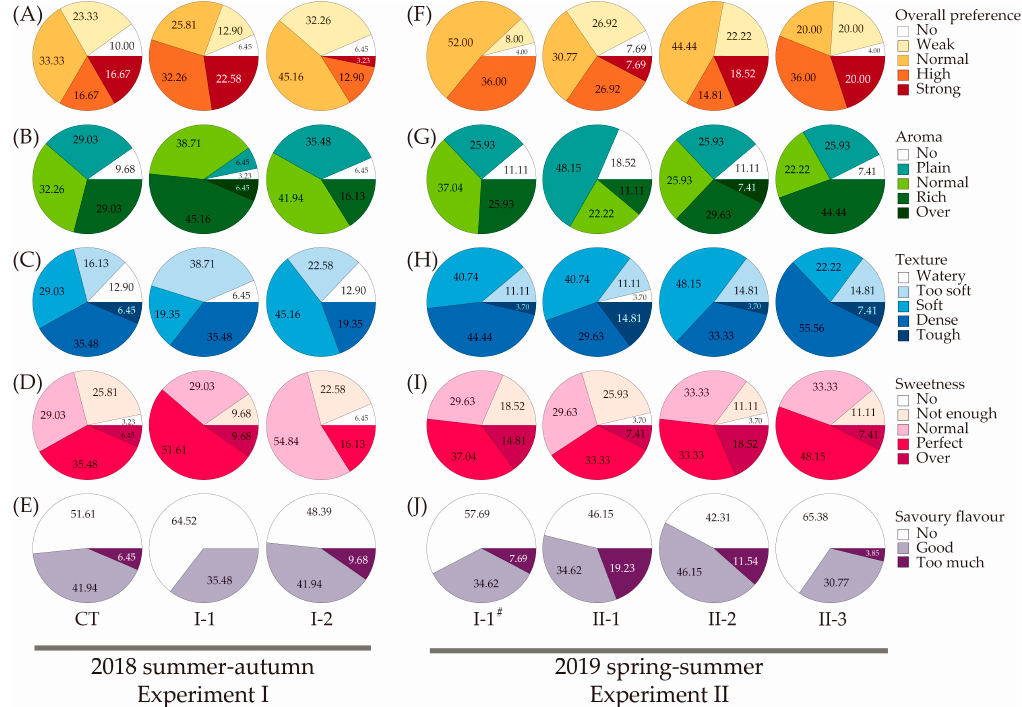
Figure 7. Pie charts showing the fractions (%) of opinions from the blind tasting tests of netted melon fruits cultivated from different nutrient treatments in Experiment I and II. In Experiment I: ( A ) overall preference; ( B ) fruit aroma; ( C ) fruit texture; ( D ) sweetness; ( E ) savoury flavour in %. In Experiment II: ( F ) overall preference; ( G ) fruit aroma; ( H ) fruit texture; ( I ) sweetness; ( J ) savoury flavour in %. Codes and details for experimental treatments refer to Tables 1 and 2.